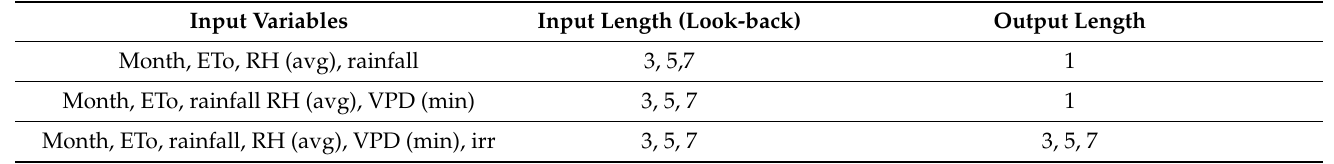
Table 4. Different inputs of the model and different input and output sizes used to train the BiLSTM model. Look-back indicates the number of days used to predict the FTSW, while irr indicates